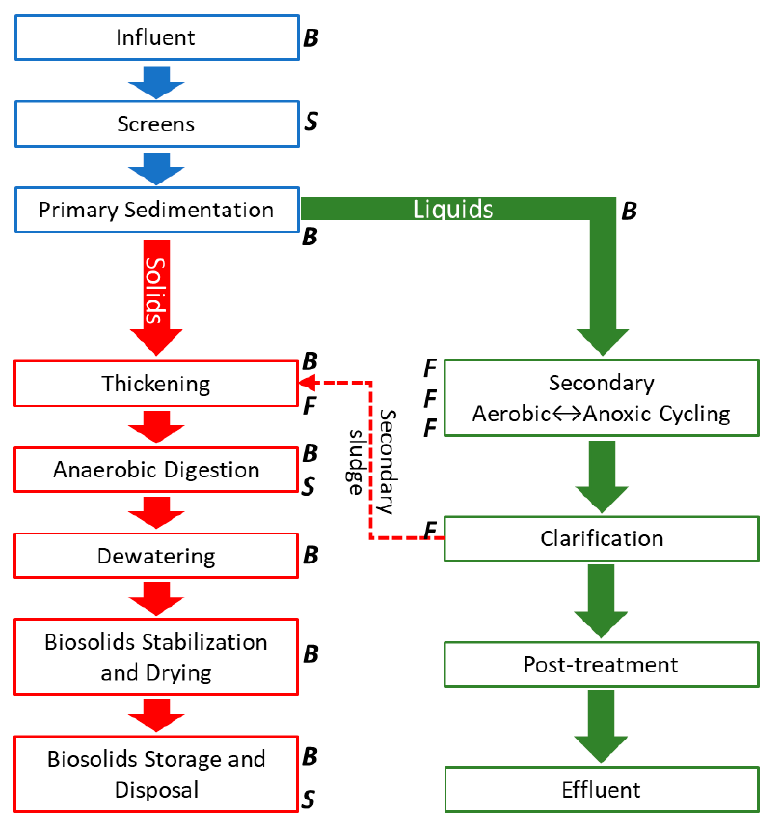
Figure 2. Schematic diagram of the process at the WWTP investigated in this study. Sampling method